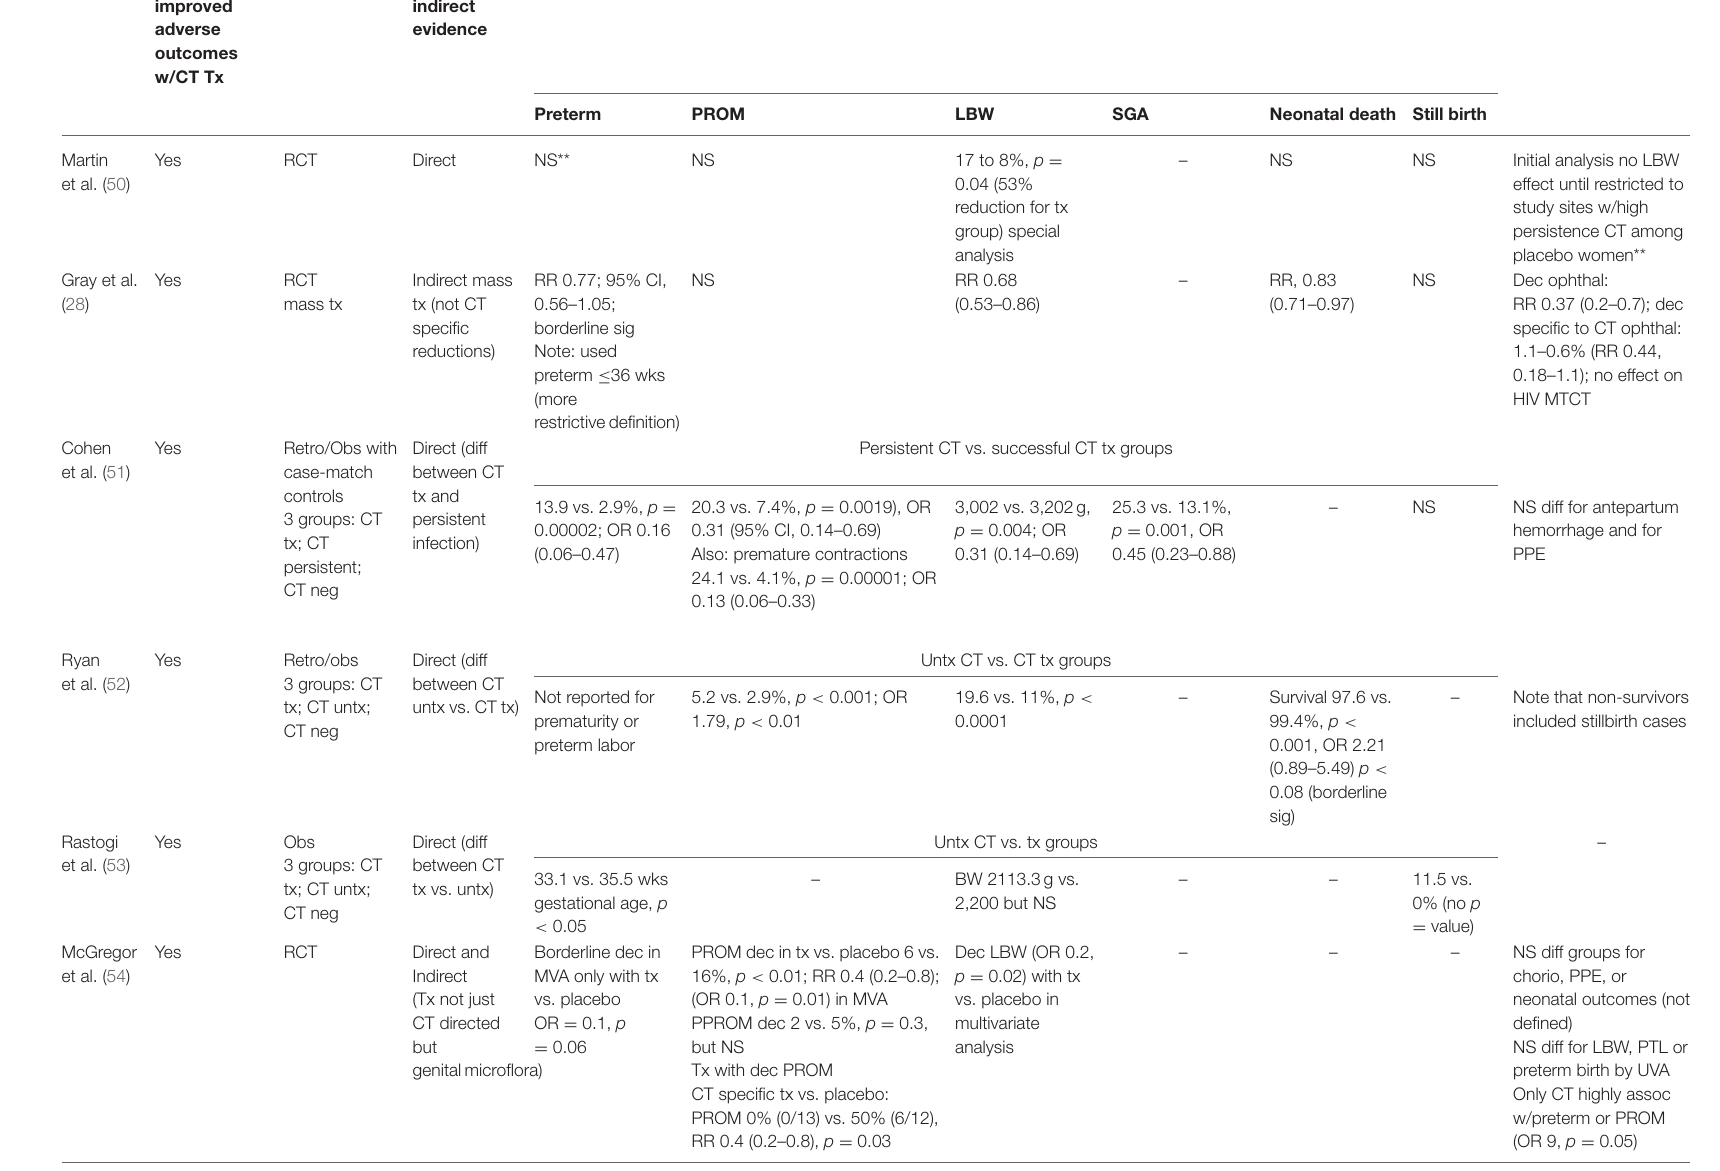
TABLE 2 | Studies of prevention of adverse pregnancy outcomes with antenatal chlamydial treatment ( N =